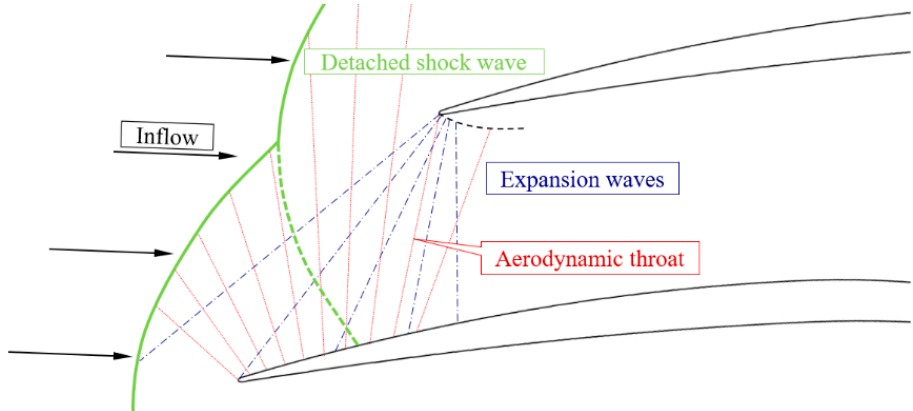
Figure 25. Schematic of the aerodynamic throat under a low supersonic inflow with a large negative incidence.